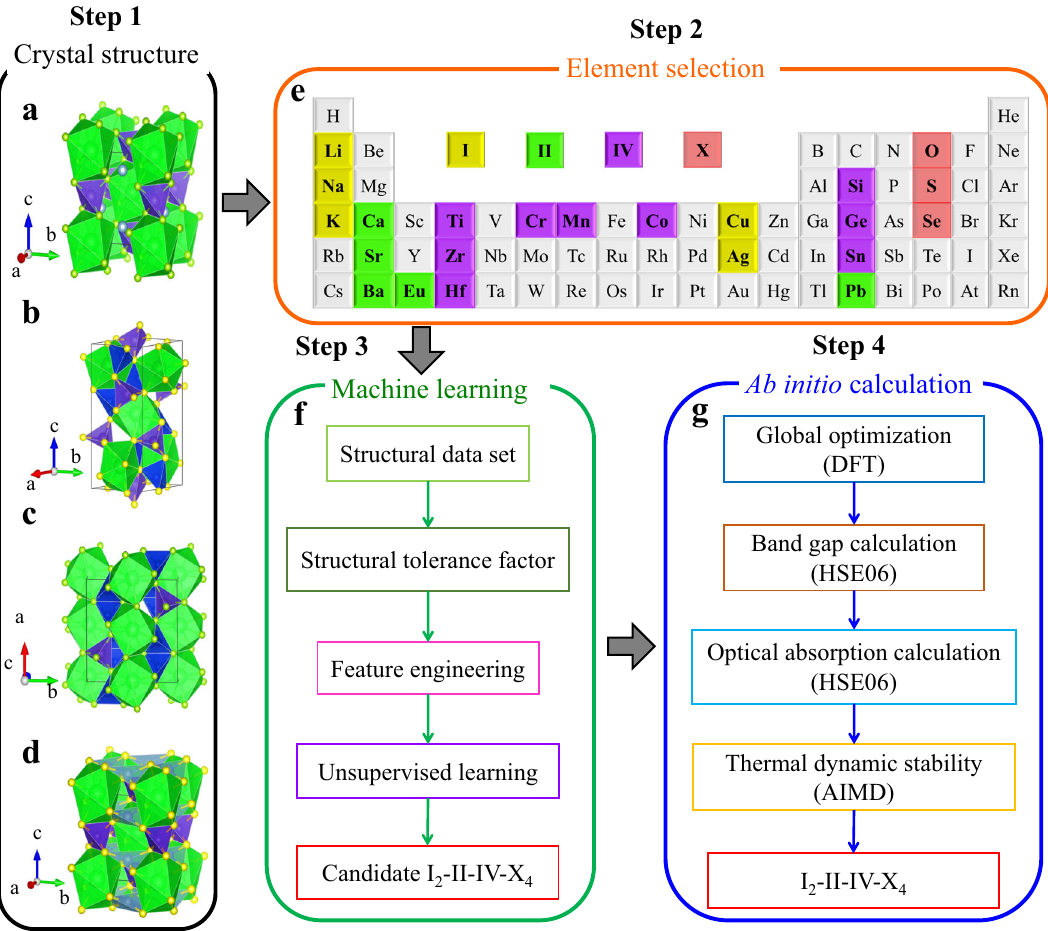
Fig. 1 Schematic of the unsupervised discovery of I 2 -II-IV-X 4 chalcogenides. a Crystallographic view of Ag 2 BaSnSe 4 ( I 222). b Crystallographic view of Cu discovery of candidate I 2 -II-IV-X 4 chalcogenides. g Further accurate veri fi cation of the I 2 -II-IV-X 4 chalcogenides through ab initio calculations. The gray arrows represent the sequential work fl